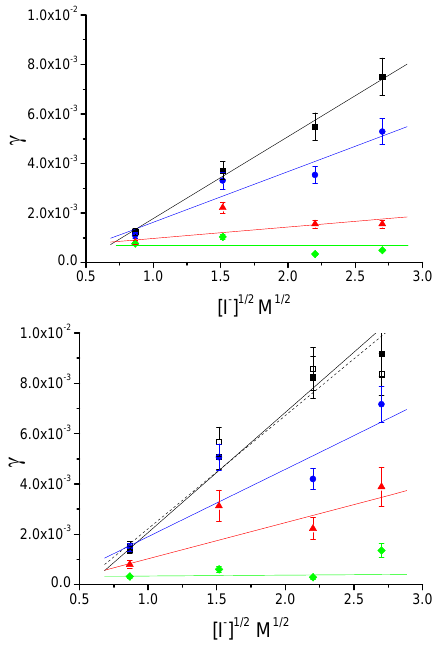
Fig. 7. Plot of the uptake coefficient as a function of the iodide con- q (cid:2) I − (cid:3) for different mass ratios of surfactant centration in terms of ( (a) for C 15 and (b) for C 18 ). For C 15 , in (a): black squares: no coating, blue circles: 3%, red triangles: 4% and green diamonds: 30%. For C 18 , in (b): black squares: no coating, open black square: 0% (at 30 ◦ C in the evaporator), blue circles: 2%, red triangles: 6% and green diamonds: 37%. The lines are linear fits to the